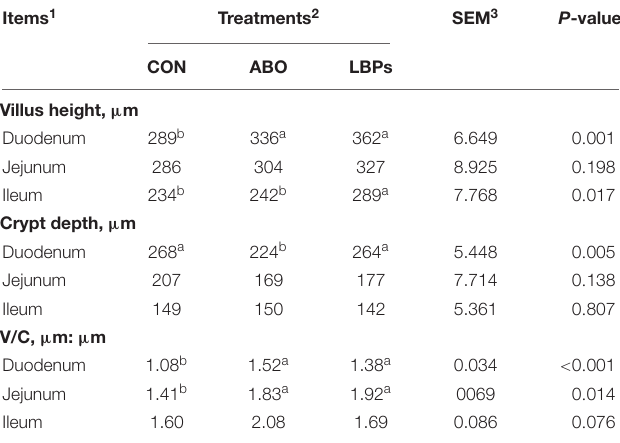
TABLE 6 | Effects of dietary LBPs supplementation on intestinal morphology of weaned piglets.